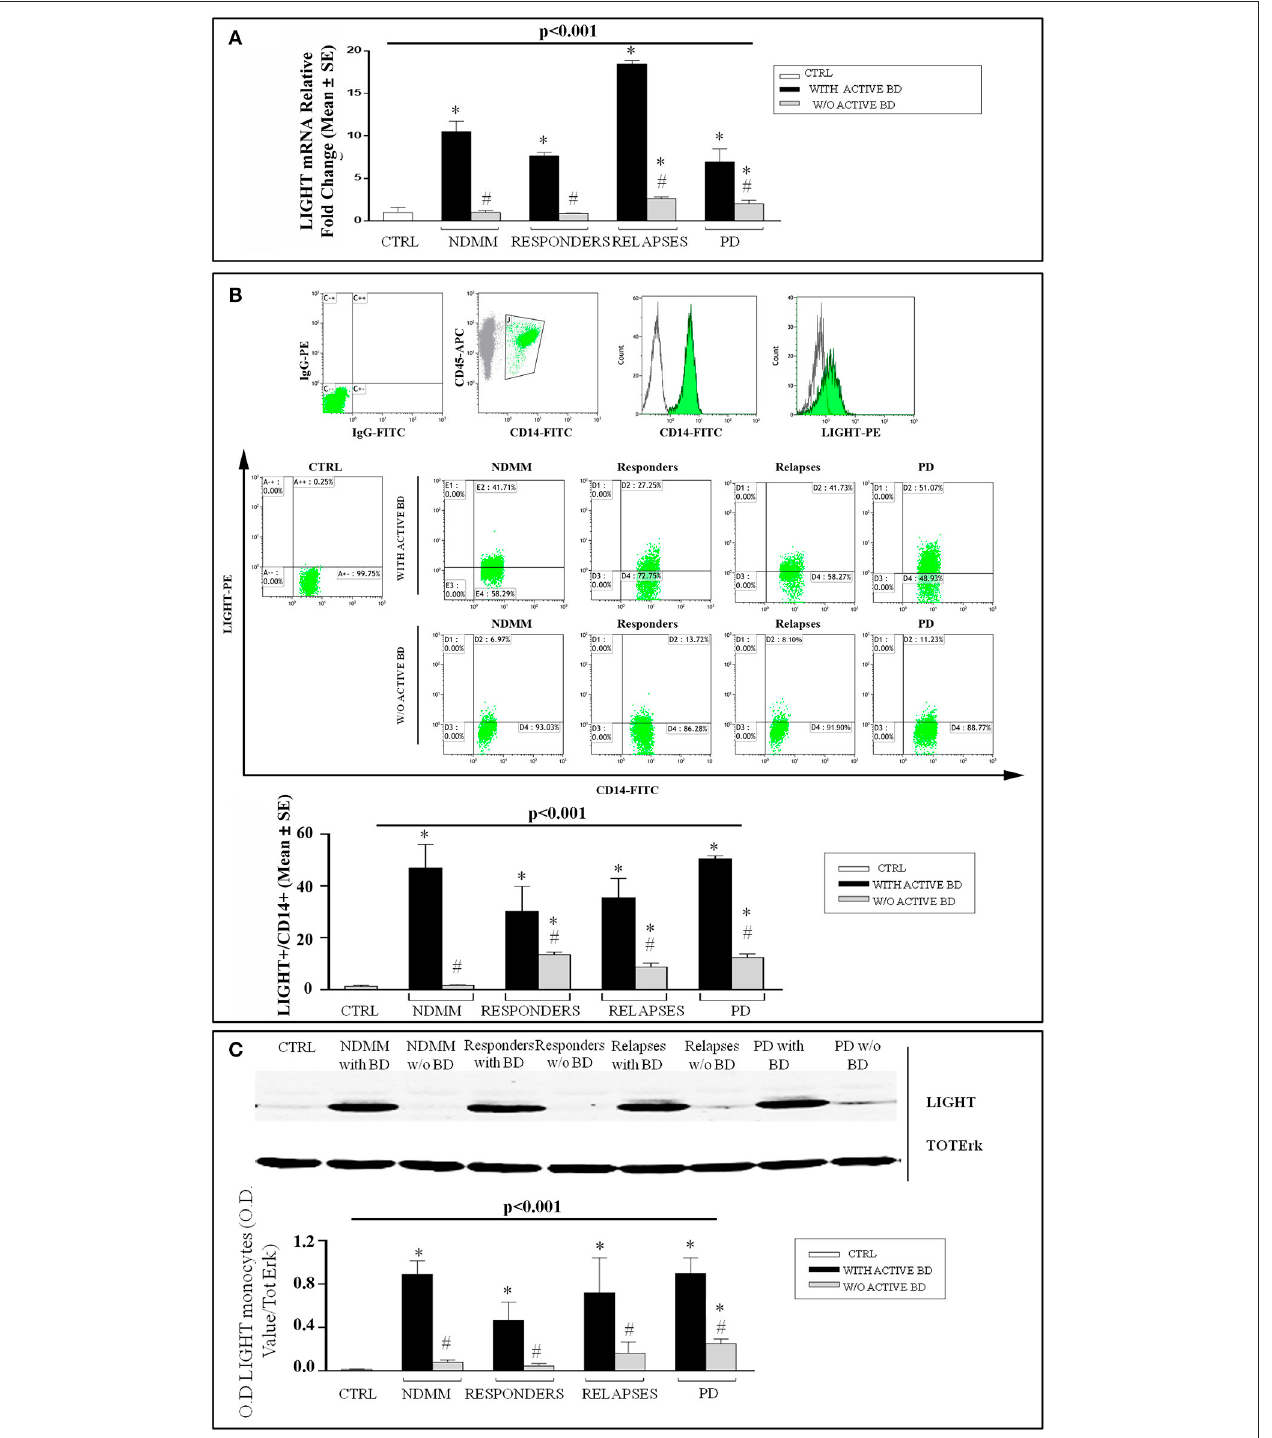
FIGURE 1 | High LIGHT expression in MM patients with active bone disease experiencing therapeutic regimens . LIGHT expression was assessed by real-time PCR (A) , flow cytometry (B) , and western blotting (C) . In the lymphomonocytes isolated from newly diagnosed multiple myeloma (NDMM) patients with active bone disease (BD), responders, at relapse and progressive disease (PD), higher LIGHT expression was detected respect to the controls (CTRL) (A) . Flow cytometry graphs show IgG-FITC and IgG-PE isotype controls, CD14 + monocytes gated on CD45 + cells, single stain of a representative CD14 + and LIGHT + cells; dot plot show LIGHT expression on CD14 + monocytes, from a representative CTRL and representative patients with NDMM, or responders, or at relapse or PD, without or with active BD.